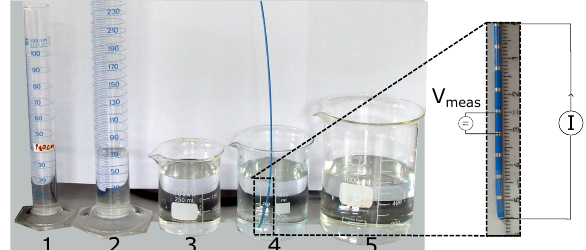
Figure 4: Left: five cylindrical glass containers represent- ing simplistic volumes to test the measurement system and calculation methods. 1: radius 13.3 mm, 2: radius 17.5 mm, 3: radius 32.8 mm, 4: radius 38.6 mm, 5: radius 50.4 mm. Right: close-up on the measurement catheter and a possible cascaded measurement configuration.